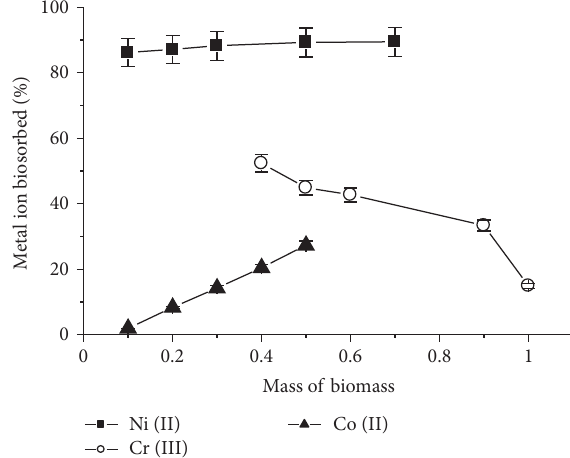
F 7: Effect of biomass dosage on the biosorption of Ni(II), Cr(III), and Co(II) using Acalypha hispida